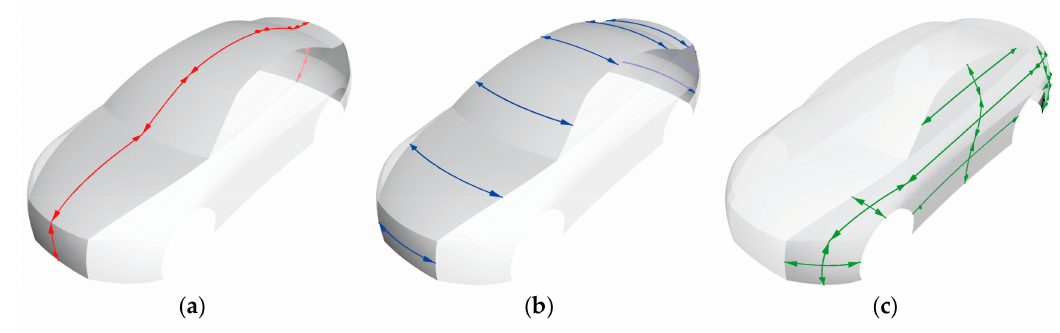
Figure 10. The di ff erence degrees d of the whole body are divided into three types according to the di ff erent surfaces and directions: ( a ) In the nine central surfaces, the type-1 di ff erence degrees d in the driving direction; ( b ) The type-2 di ff erence degrees d in the left–right direction; ( c ) The type-3 di ff erence degrees d on the other